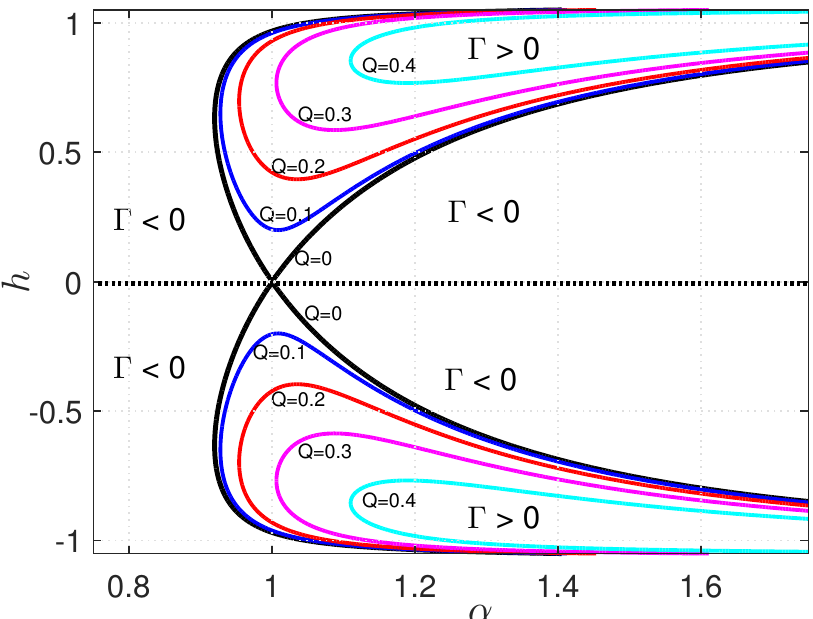
Figure 4. Transition curves ( Γ ( h , α , Q ) = 0) at different values of Q = 0, 0.1, 0.2, 0.3,